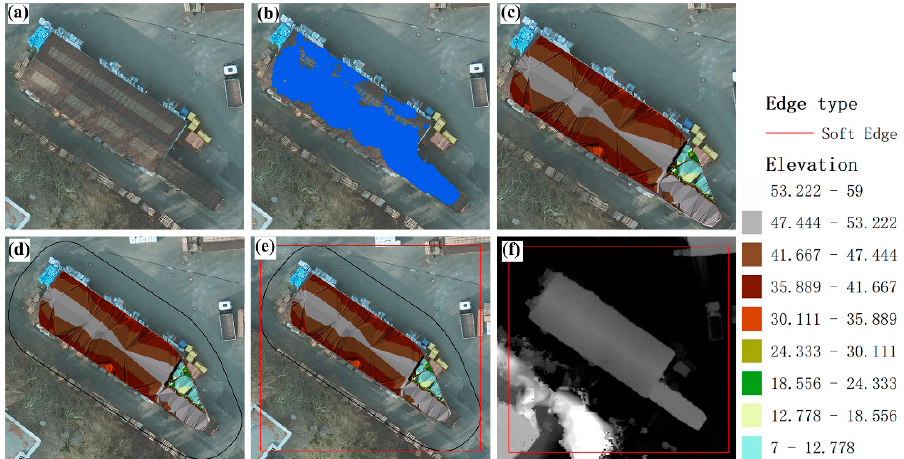
Figure 5. Individual building patch generation. ( a ) The high resolution optical images, ( b ) building footprints detected by CNN and clustered together for an individual building, ( c ) Tin generated based on the individual building footprints, ( d ) the buffer area of the Tin domain (marked with black curve), ( e ) MBR of the buffer (the red rectangle), and ( f ) individual NDSM building patch cropped by the MBR.